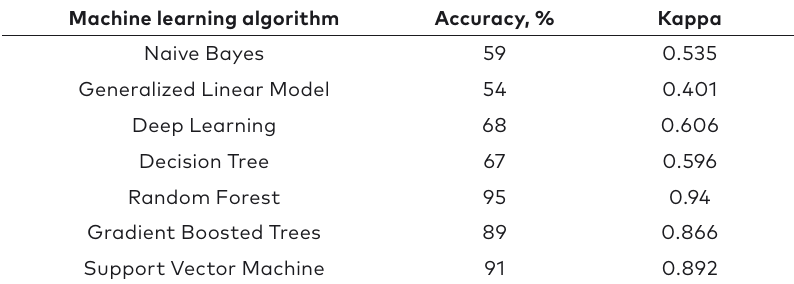
Table 5. The accuracy of several machine learning techniques tested